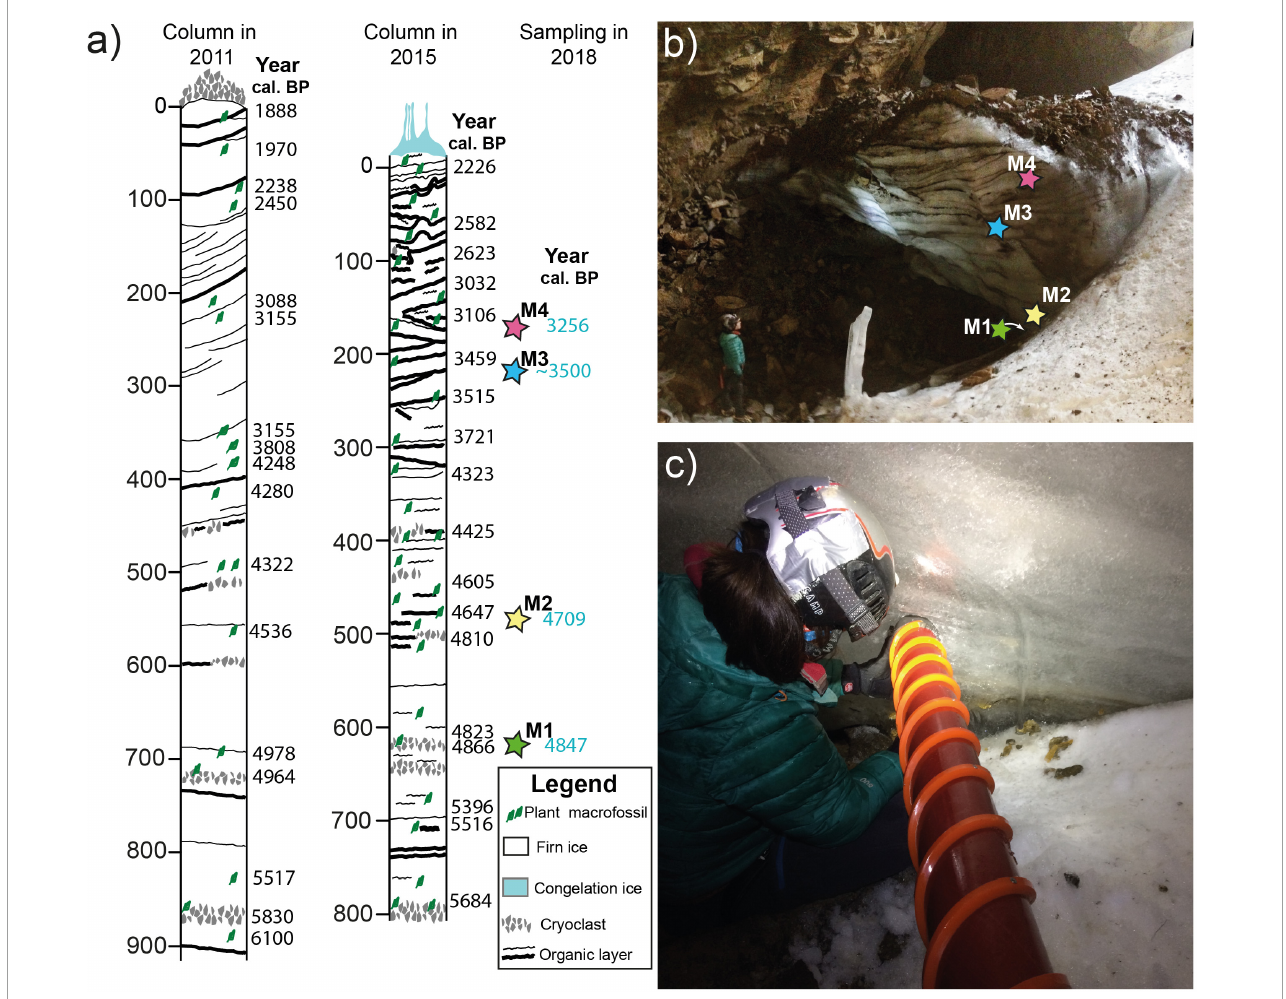
FIGURE2 Stratigraphy and ice sampling. (a) Stratigraphy and chronology of the ice deposit in 2011 (Sancho et al., 2018) and 2015 (Leunda et al., 2019) together with the position of the samples taken in 2018 for the present study. (b) View of the ice body in 2018 and the approximate position of the samples taken. (c) Ice sampling using the ice auger. M1, M2, M3, and M4, names of the samples; Cal. BP, calibrated years before the